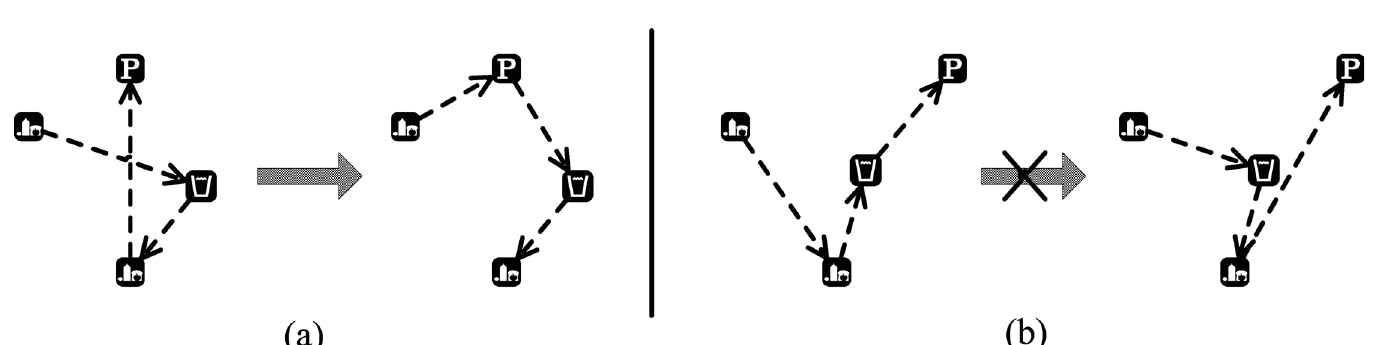
Fig 6. Results of nearest neighbor